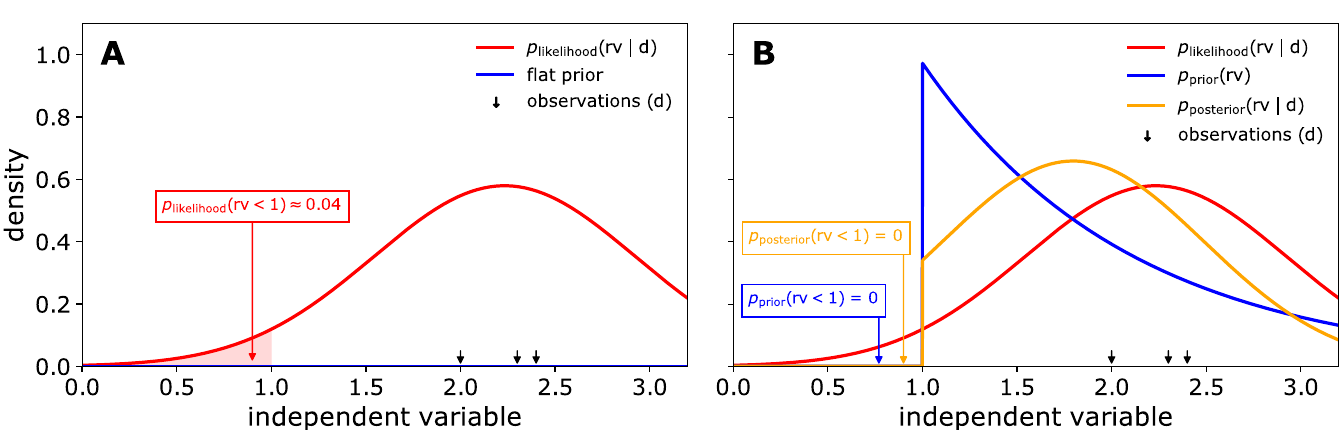
Fig 1. Comparison of likelihoodist and Bayesian probability densities. Using a N noise model, the likelihood function normalized by its integral gives a likelihoodist probability density function (red) for the independent variable. In A the resulting probability that the variable of interest lies below 1 is clearly positive. In a hypothetical scenario where the variable of interest is known to be � 1, a shifted exponential prior could be assigned ( B ). The posterior probability (orange) is then obtained via Bayes’ rule (Eq 1) and gives the desired 0 probability of the variable being less than 1. A may be viewed as a special case of the Bayesian perspective with a flat prior (blue). Observations and distribution parameters were chosen to obtain a good layout: s ¼ 1 : 2 ; 1 ¼ 1 : 1 , d = [2.0, 2.3, 2.4]. l